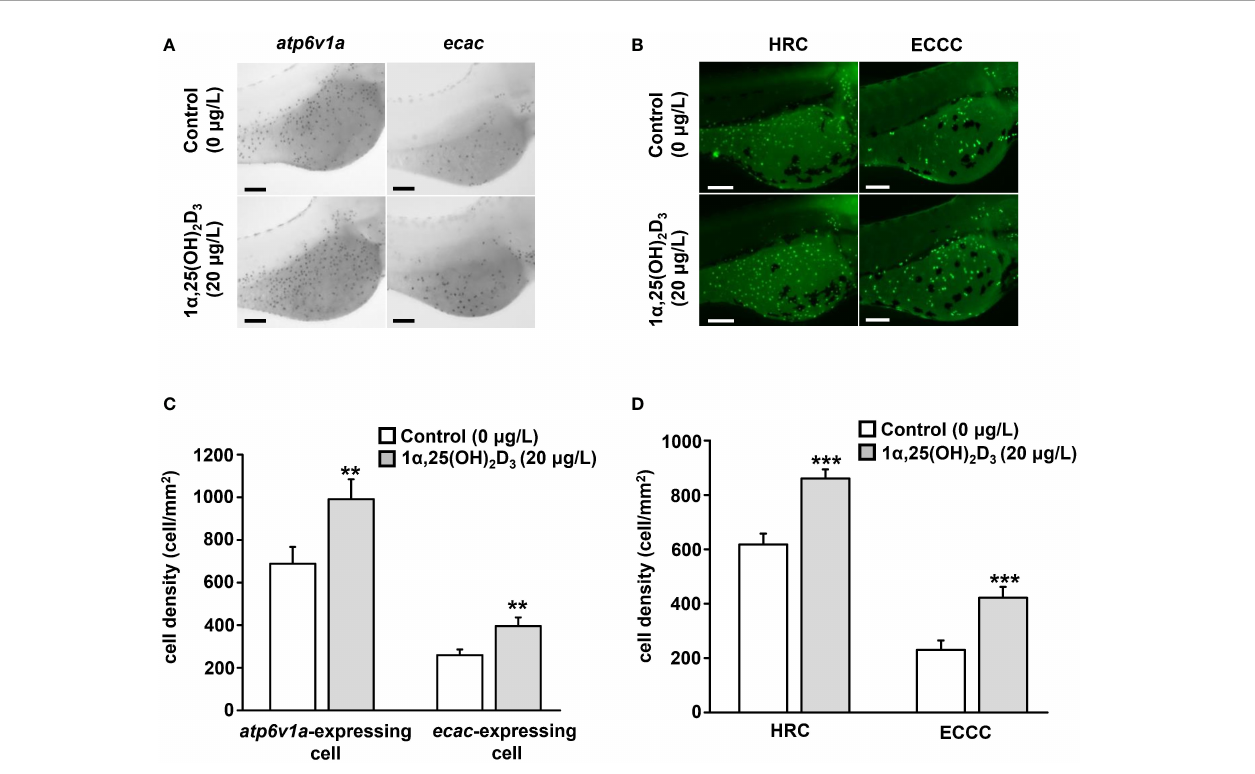
FIGURE 3 Effects of exogenous 1 a ,25(OH) 2 D 3 treatment on the density of ionocytes at the embryonic skin of 3 dpf zebra fi sh larvae. (A) The representative images of whole mount in situ hybridization showing the expression of atp6v1a and ecac -expressing cell (black dots) in the yolk sac of zebra fi sh larvae treated with 0 (control) and 20 m g/L 1 a ,25(OH) 2 D 3 . (B) The representative images of whole-mount immunocytochemistry showing the expression of H + -ATPase- rich cell (HRC) and ECaC-expressing cell (ECCC) (green dots) in the yolk sac of zebra fi sh larvae treated with 0 (control) and 20 m g/L 1 a ,25(OH) 2 D 3 . (C, D) The quantitative data for the cell density. Values are the mean ± SEM ( n = 9). Student ’ s t-test, ** p <0.01, *** p <0.001. Scale bar: 100 m